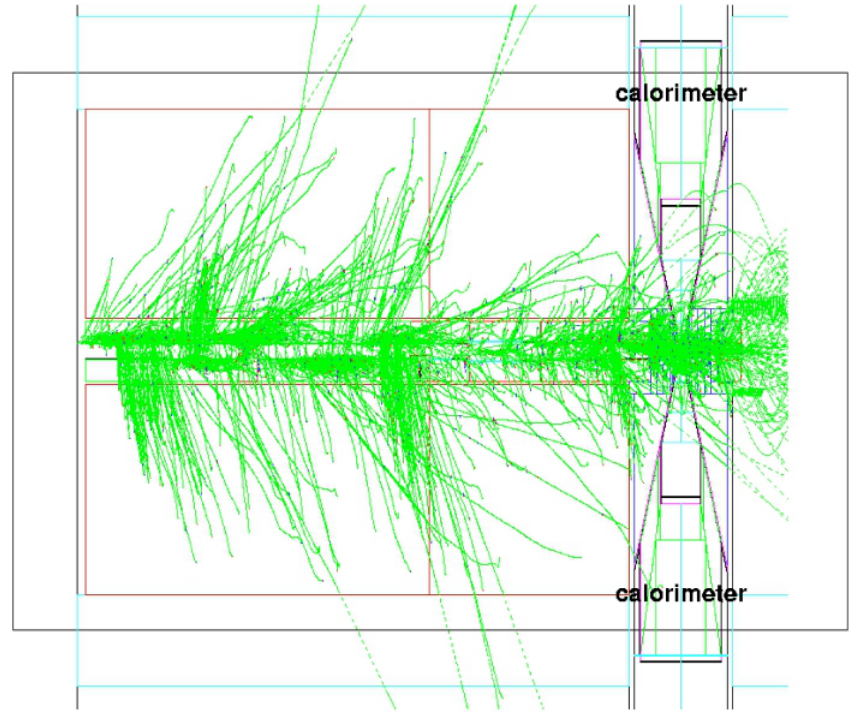
FIG. 67. (Color) Trajectories of typical Bethe-Heitler muons from their source in the shielding around the beam pipe to the detector for a 4 TeV COM collider. As indicated in the text the scales are extremely distorted, the total horizontal length is (cid:2) 130 m, and the outer edge of the calorimeter is (cid:2) 4 m. Notice that , 1% of the tracks end in the calorimeter (see Table